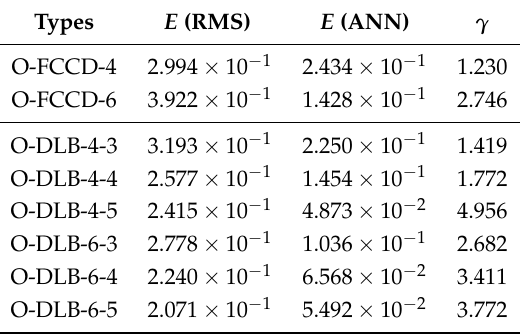
Table 4. The same as Table 3, but for the surrogate models using the datasets whose parameters are the wind turbine airfoil’s geometric and operational